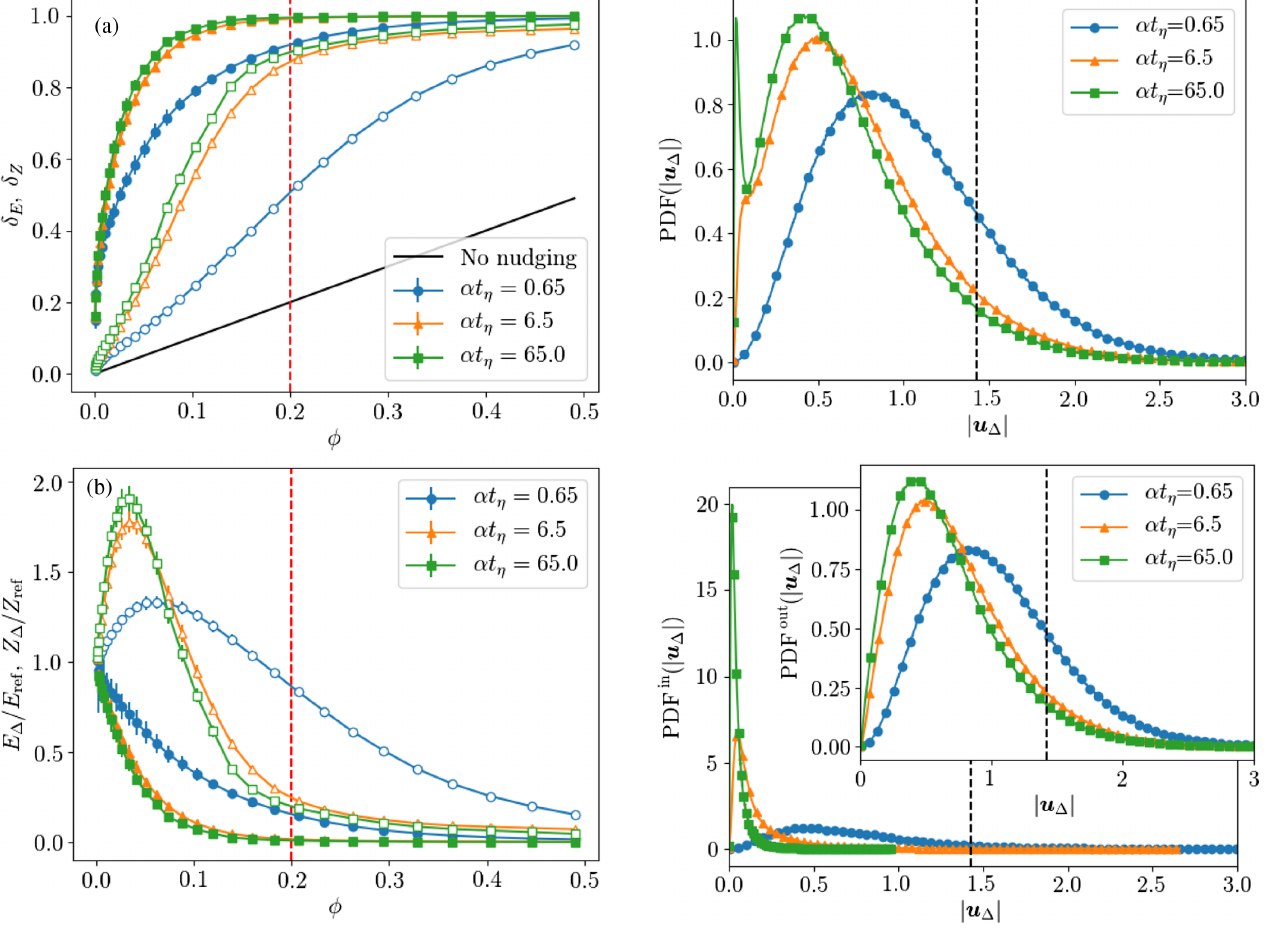
FIG. 4. (a) Values of the velocity correlations δ E (filled FIG. 5. Histograms of the point-by-point reconstructing error symbols) and the vorticity correlations δ Z (empty symbols). j u Δ j measured in the whole volume (top), only inside the nudging (b) Values of the energy error E Δ =E (filled symbols) and regions (bottom), and only outside (inset). The vertical dashed ref the enstrophy errors Z Δ =Z (empty symbols). All values are lines represent hj u . ref ref ji plotted as a function of the volume fraction ϕ and for different values of the nudging amplitude α . Solid line in (a) represents the linear scaling expected for no effects of nudging (see text). The dashed red vertical lines mark the value ϕ c ¼ 0 . 2 as the typical estimate for transition to maximum synchronization in these setups. Here and in all figures error bars are always plotted; when they are not visible it means that they are smaller than the symbol size. See Sec. II C for the definitions of the different quantities and their errors.